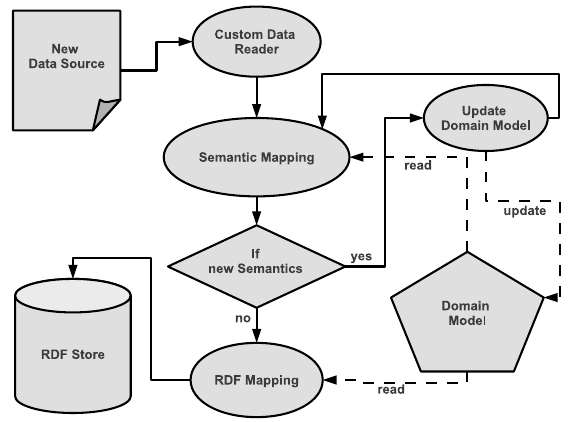
Figure 1: Flow diagram of the data integration